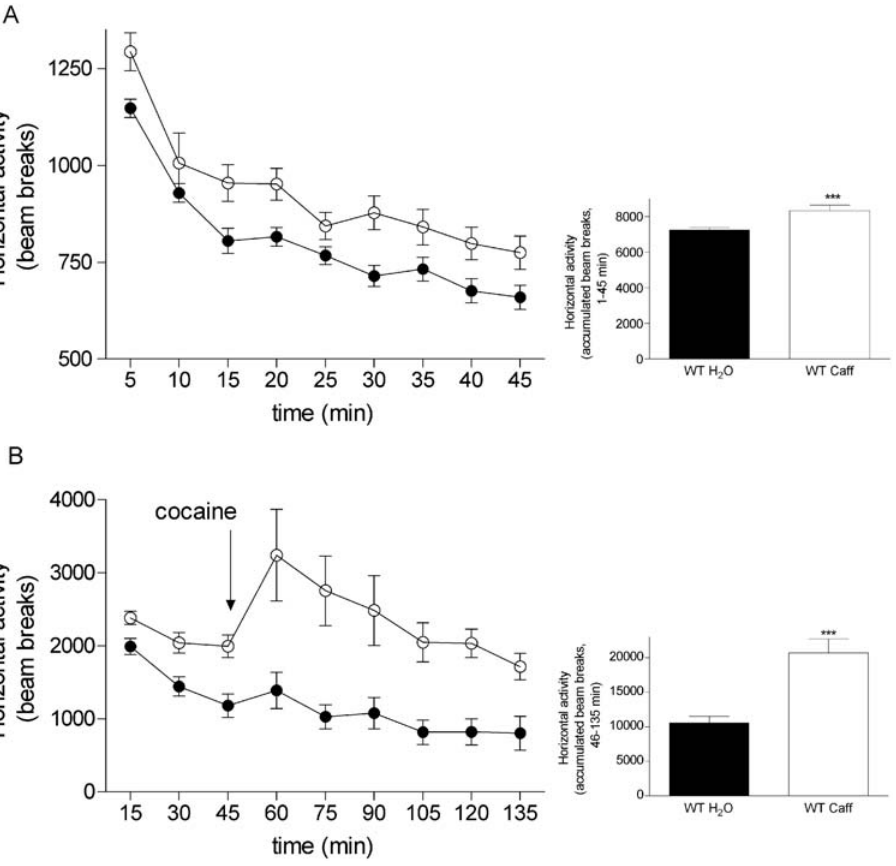
Figure 2. Spontaneous horizontal activity measurements after caffeine exposure. (A) Spontaneous horizontal activity measurements in adult wild type females exposed to 0.3 g/l caffeine (WT Caff) from GD1 to PND21 (white circle) and WT group receiving tap water (WT H 2 O, black circle). Each point represents the mean 6 S.E.M of the beam breaks recorded during 5 minute intervals. Statistical analysis was performed with Student’s t test (females WT H 2 O, n=25, WT Caff n=12, ***p , 0.01). (B) Analysis of open field behavior in two month-old female mice after stimulation with cocaine (10 mg/kg, 90 min recording). Horizontal activity was recorded during habituation 3 (min 1–45) and after cocaine stimulation (min 46–135). Each point represents the mean 6 S.E.M (females WT H 2 O n=8, WT Caff n=7) of the beam breaks recorded during 15 minute intervals for habituation 3 and cocaine challenge. Arrows indicate the time of cocaine injection. Statistical analysis was performed using Student’s t test (***p , 0.001 significantly different from WT H 2